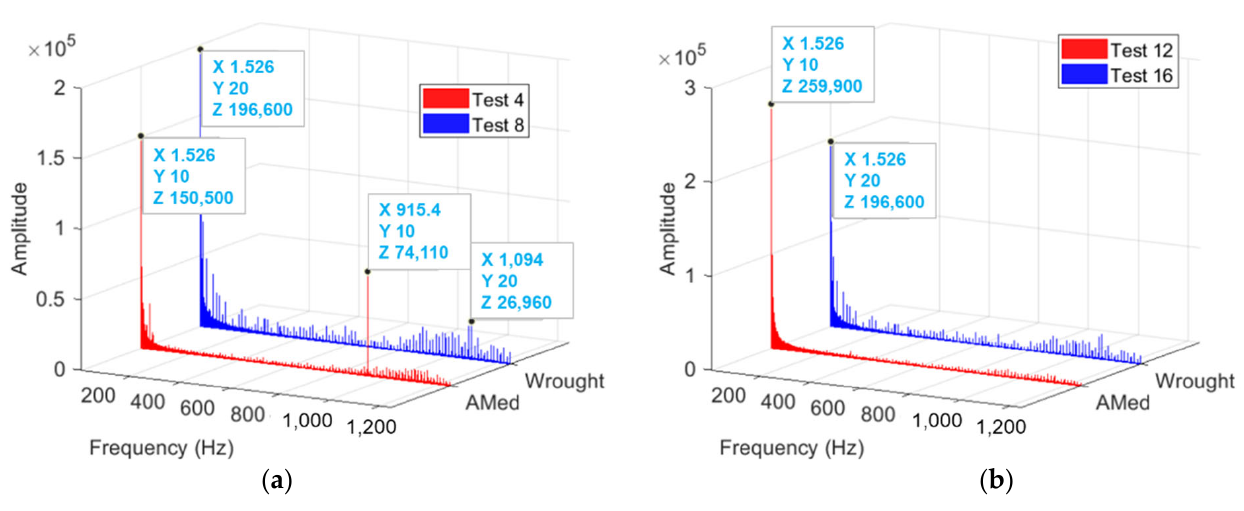
Figure 11. FFT of the signal of radial force when machining wrought and SLMed Ti6Al4V materials at the speed of 120 m/min and feed of 0.1 mm/rev: ( a ) at the cutting depth of 0.25 mm, ( b ) at the cutting depth of 0.5 mm.